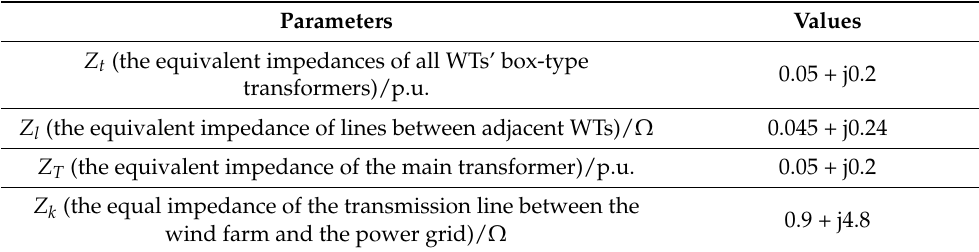
0.05 + j0.2 0.045 +